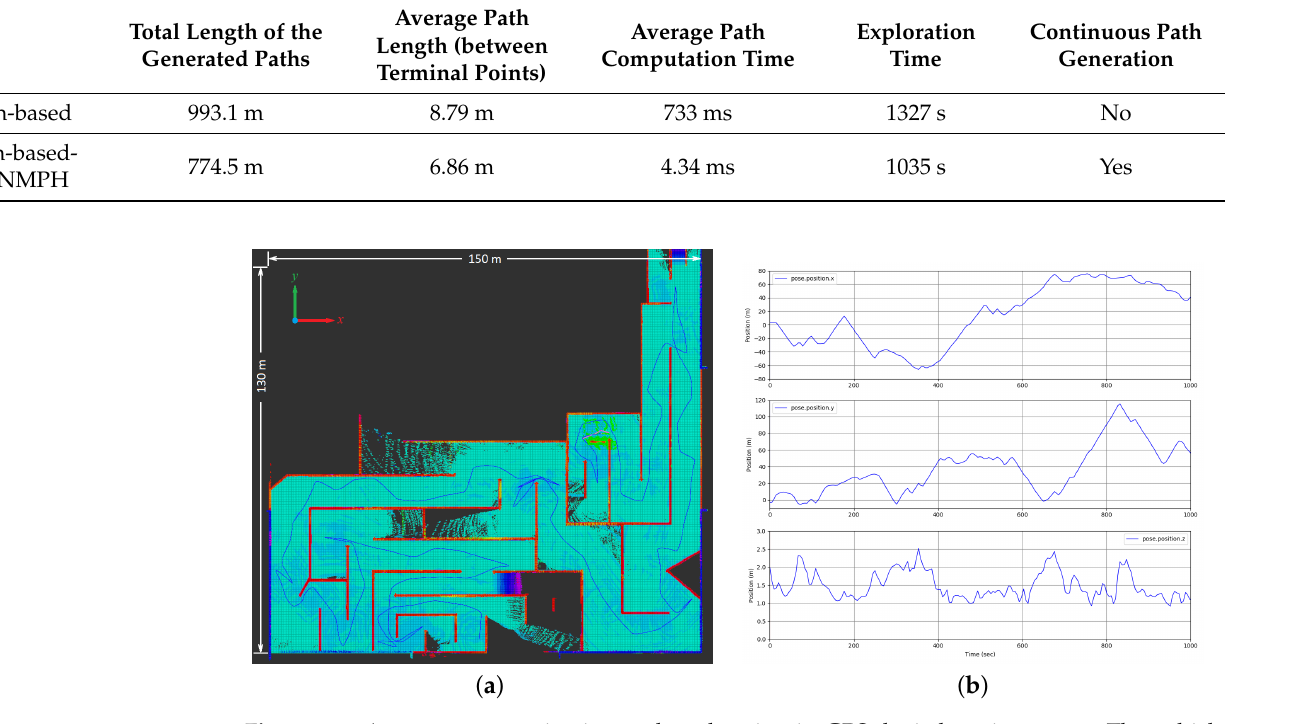
Figure 13. Autonomous navigation and exploration in GPS-denied environment. The vehicle travelled a total distance of 774.5 m in about 1035 s. ( a ) Overhead visualization of exploration path through environment. ( b ) Plot of vehicle positions (x,y,z) versus